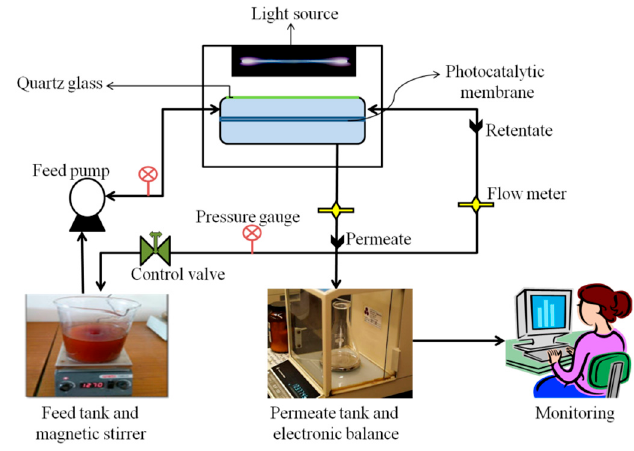
Figure 2. Self-designed continuous cross-flow setup utilized in this study.